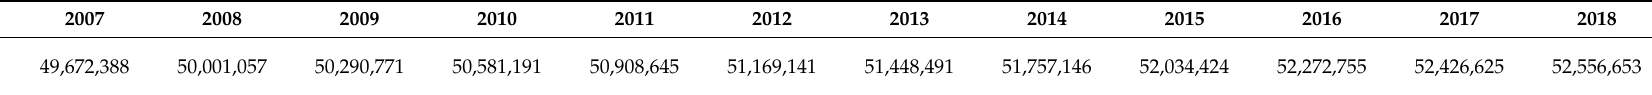
Table 2. Actual numbers and incidence rates of thalassemia in the Korean population